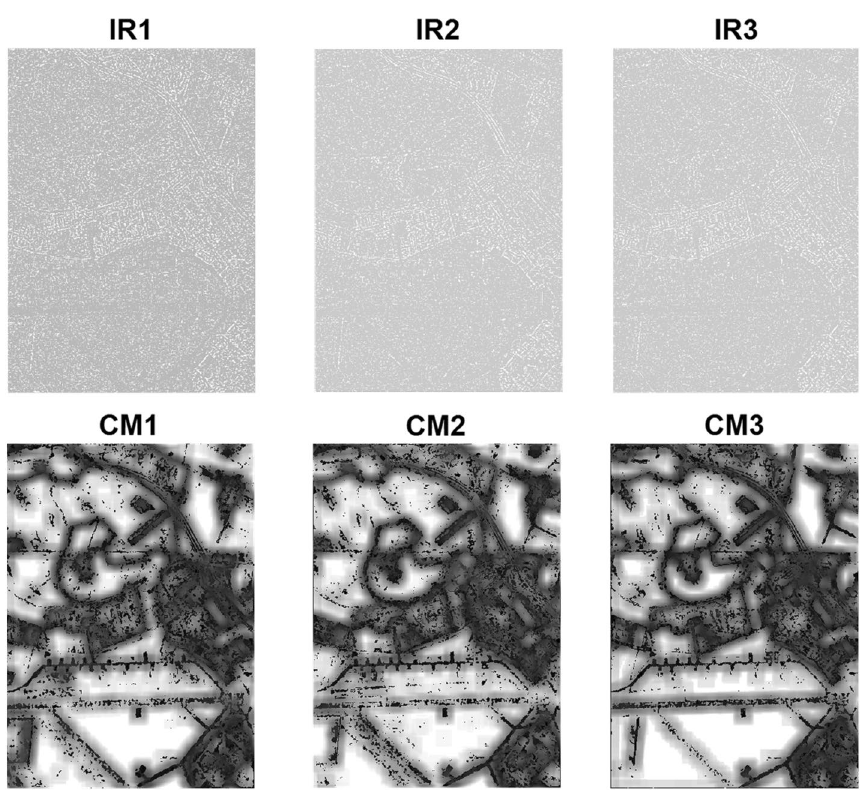
Figure 6. Important regions (IRs) and confidence maps (CMs) for three views of Oberpfaffenhofen